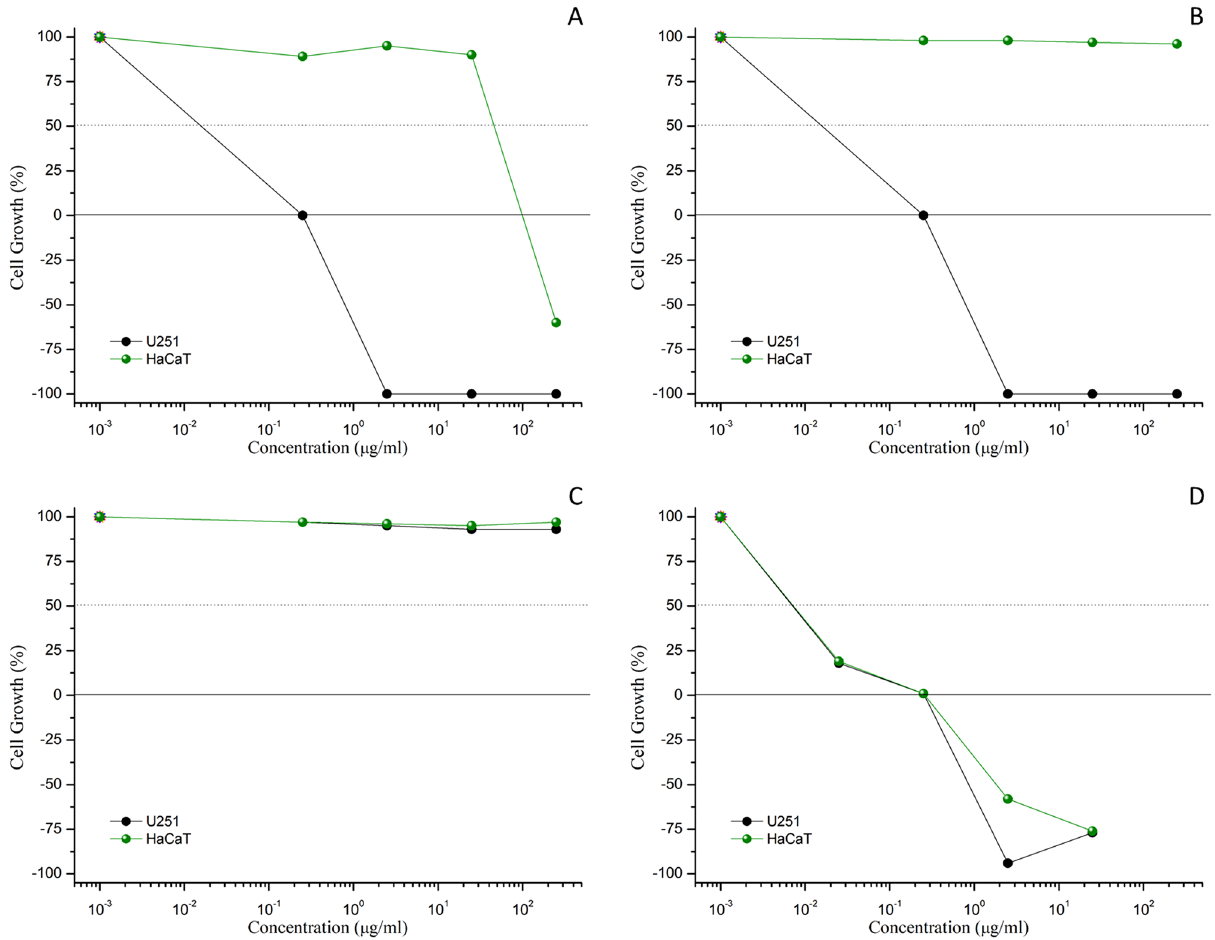
Figure 4. Antiproliferative activity of free bromelain solution ( A ), chitosan-bromelain nanoparticles ( B ), chitosan nanoparticles ( C ), and doxorubicin ( D ), after 144 h exposition. Data is presented as mean ± standard deviation; n = 3. Graphs were created by authors using average data with standard deviation (n = 3) from antiproliferative assay, using Origin software (version 8.1.34.90, OriginLab